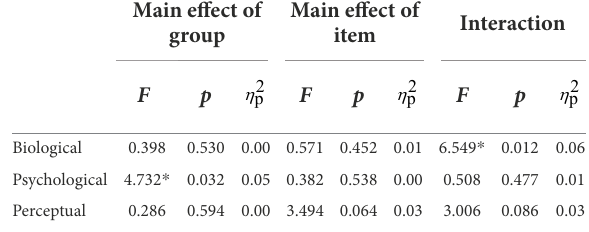
TABLE 4 Comparisons between children with hierarchical and egalitarian IC relationships in agency attributions to ToM and Random animations.